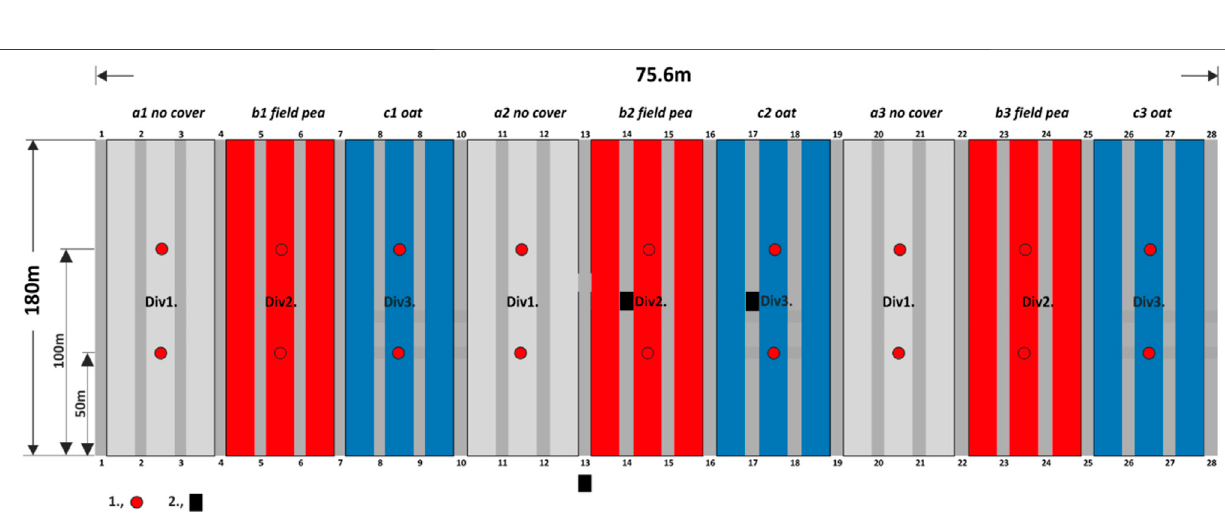
Frontiers in Environmental Science |